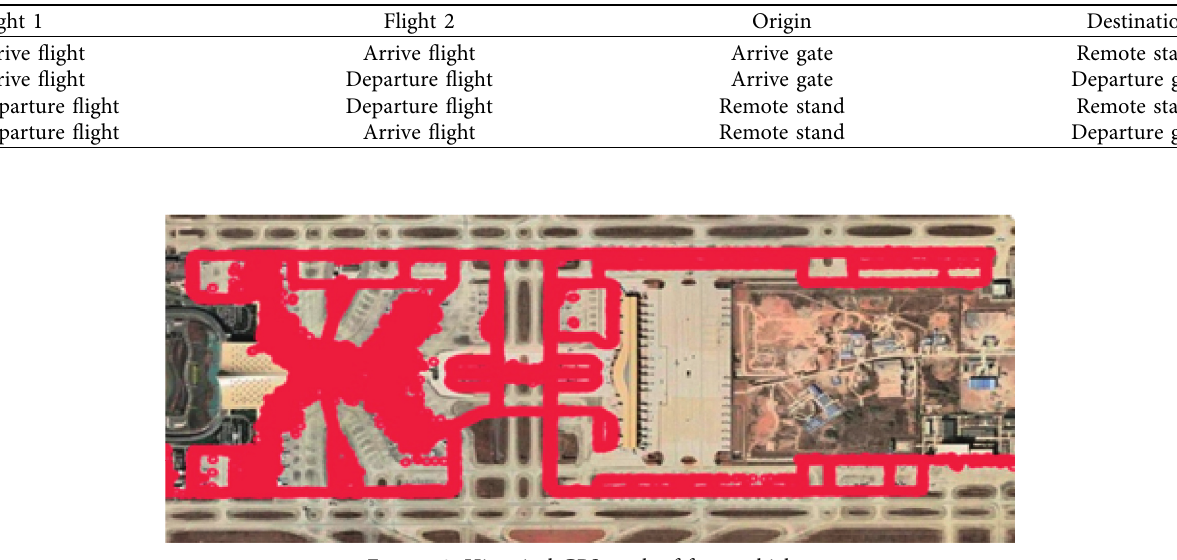
Figure 2: Historical GPS track of ferry vehicles.